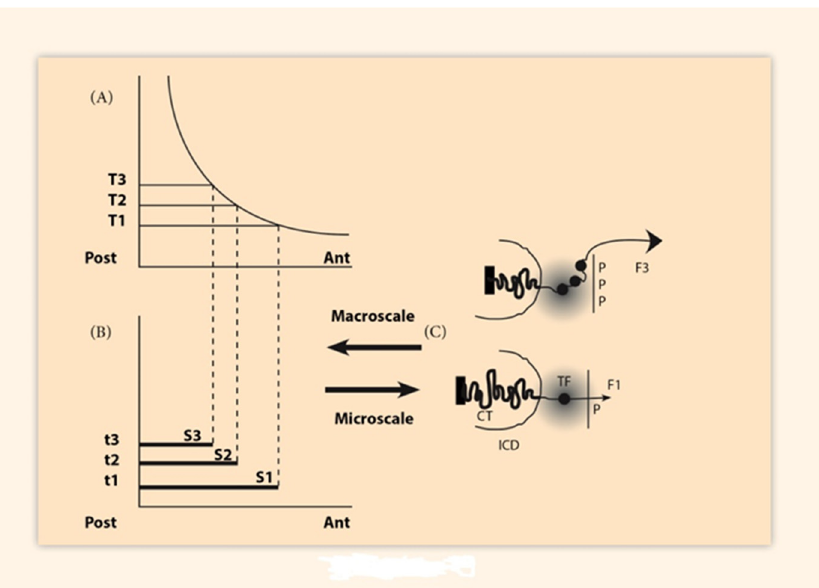
Figure 1. Morphogen gradient and Hox gene clustering. (Adapted from Y. Almirantis et al. Current Genomics, 2013, 14 (279–288). ( A ). Concentrations’ thresholds (T1, T2, T3) ( B ) Time sequences (t1, t2, t3) and corresponding domains (S1, S2, S3) determine the Hox1, Hox2, Hox3 activation in space and time. ( C ) (bottom) In an anterior cell of S1, a small force F1 pulls Hox1 (black spot) out of the chromatin territory (CT) toward the Interchromosome domain (ICD) and the regime of the Transcription Factory (TF) (grey domain). Allocation of polar molecule P opposite the telomeric end of the Hox cluster. At a later stage (top), in a more posterior location of S3, a stronger force F3 pulls Hox1, Hox2, Hox3 out of CT in the TF. (Allocation of 3P molecules).